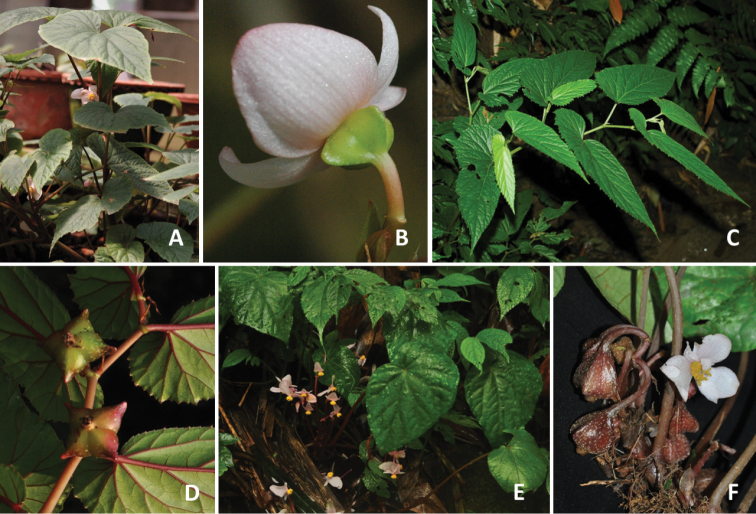
Begonia
× lancangensis and its parents (B.
acetosella and B.
handelii) (Photos by Daike Tian) A, B male plant and female flower of B.
× lancangensisC, D plant and fruits of B.
acetosellaE, F male and female flowering plants of B.
handelii.